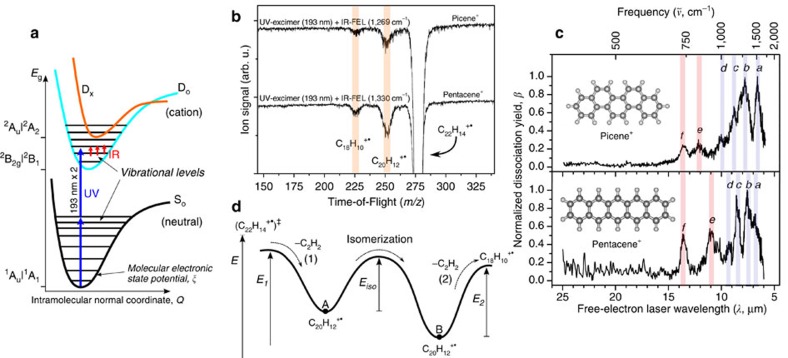
Laser photoexcitation dynamics and multiple-photon dissociation action spectra.(a) Schematic of adiabatic electronic potentials involved in ultraviolet and infrared photo-excitations leading respectively to charged Do-state aromatic monomers and vibrational infrared action spectra. The spin-doublet excited state Dx closest to the ground state Do is defined by the singly excited configuration Ψi(4a2→4b1) for picene+ and Ψi(2au→3b2g) for pentacene+ (Supplementary Tables 1 and 2). The y-axis equilibrium electronic energy (Eg) shows the corresponding ground-state molecular terms. (b) Typical mass analysis upon ultraviolet photoionization and infrared FEL macropulse irradiation. The ionization energies of picene and pentacene are 7.5 and 6.6 eV, respectively19, and the excess of vibrational excitation determined by the Franck–Condon overlaps of neutral- and cationic-state vibrational wavefunctions partially evolves as C2H2-loss dissociation (Methods). (c) Infrared action spectra (β(λ)) retrieved from C20H12+· (m/z 252) and C18H10+· (m/z 226) ion signals recorded continuously along tuned FEL photon energy (action bands characterized in Table 1). (d) Proposed scheme of multiple-photon induced dissociation kinetics along the potential energy reaction profile (reaction coordinate from left to right) connecting the reactant C22H14+· parent ion (as transition state ‡)35 with C2H2-loss product ion (A), the intermediate isomerization34 product ion (B), and the C4H4-loss product ion (C18H10+·). The energy barriers E1, Eiso, and E2 correspond to first C2H2-loss (1), isomerization and second C2H2-loss (2) reactions. Figure 6 confirms that the two product ions (both exhibit same spectral features) arise from the same parent; hence, the possible event of sequential photon absorption by the intermediate B structure does not influence the spectra.